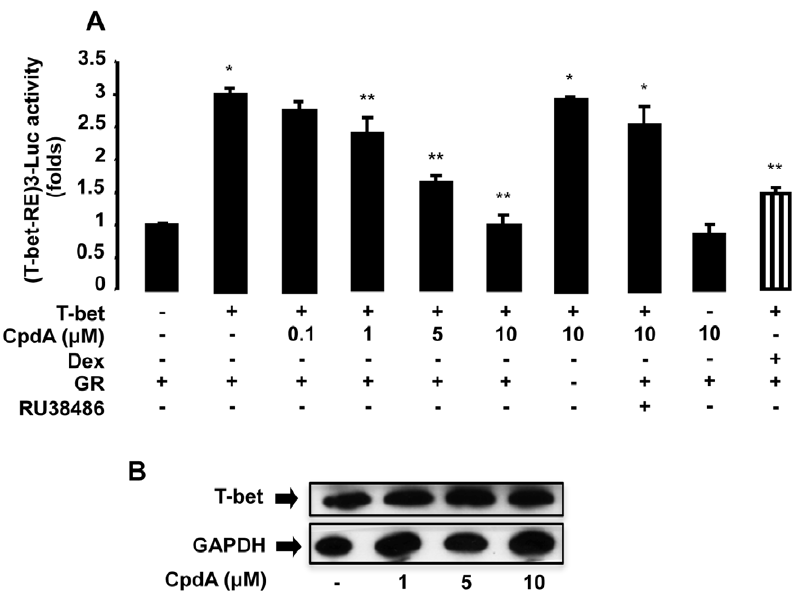
Figure 1. Compound A inhibits T-bet transcriptional activity. A, EL4 cells were transfected with 9 m g of a reporter plasmid which contains T- bet response elements upstream of the luciferase gene (T-bet-RE-Luc) with or without 9 m g of T-bet and GR expression vectors. After 16 h in culture, cells were stimulated for 5 h with or without Compound A (CpdA, 0.1, 1, 5 and 10 m M), Dexamethasone (Dex, 10 nM) or the GR specific antagonist RU38486 (1 m M). Results, as folds, normalized to b -galactosidase activity, are expressed as mean 6 SEM (n = 6, * p , 0.001 vs. basal without T-bet, ** p , 0.05 vs. T-bet without CpdA), averaged from three independent experiments. B, Lysates obtained from transfection experiments performed under similar conditions as mentioned above, were prepared for T-bet analysis by Western Blot. Single bands corresponding to T-bet were obtained. GAPDH signal was used as loading control; one of three independent experiments with similar results is shown.